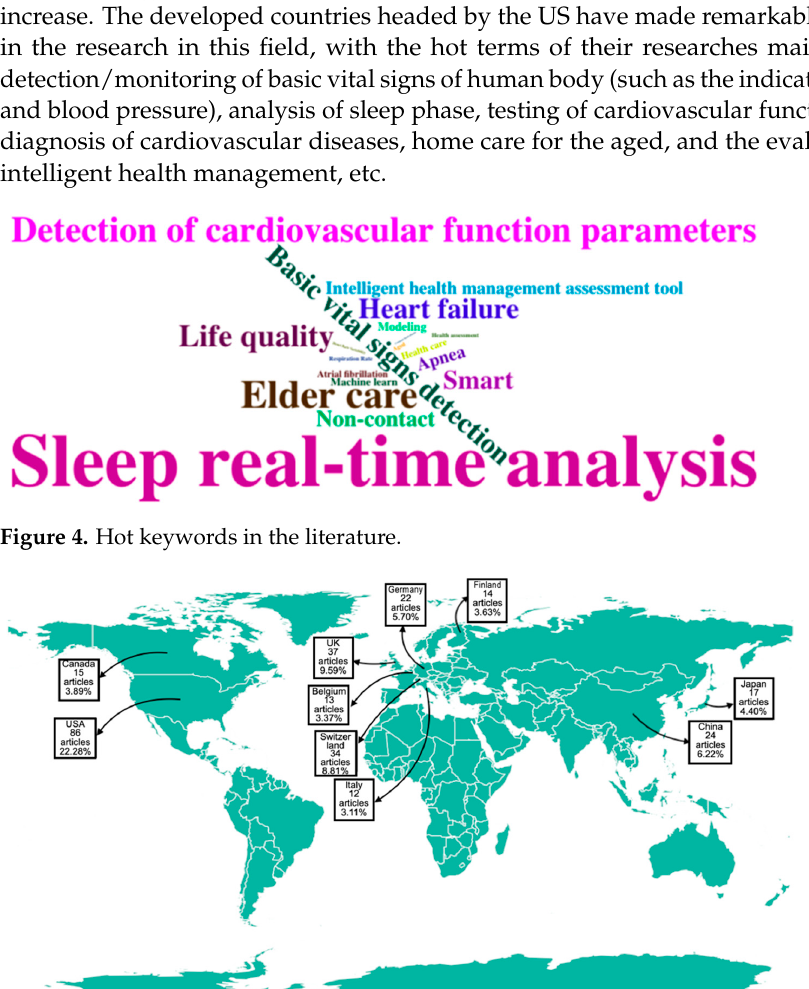
Figure 5. Distribution in countries/regions for contribution of the literature on BCG/SCG.